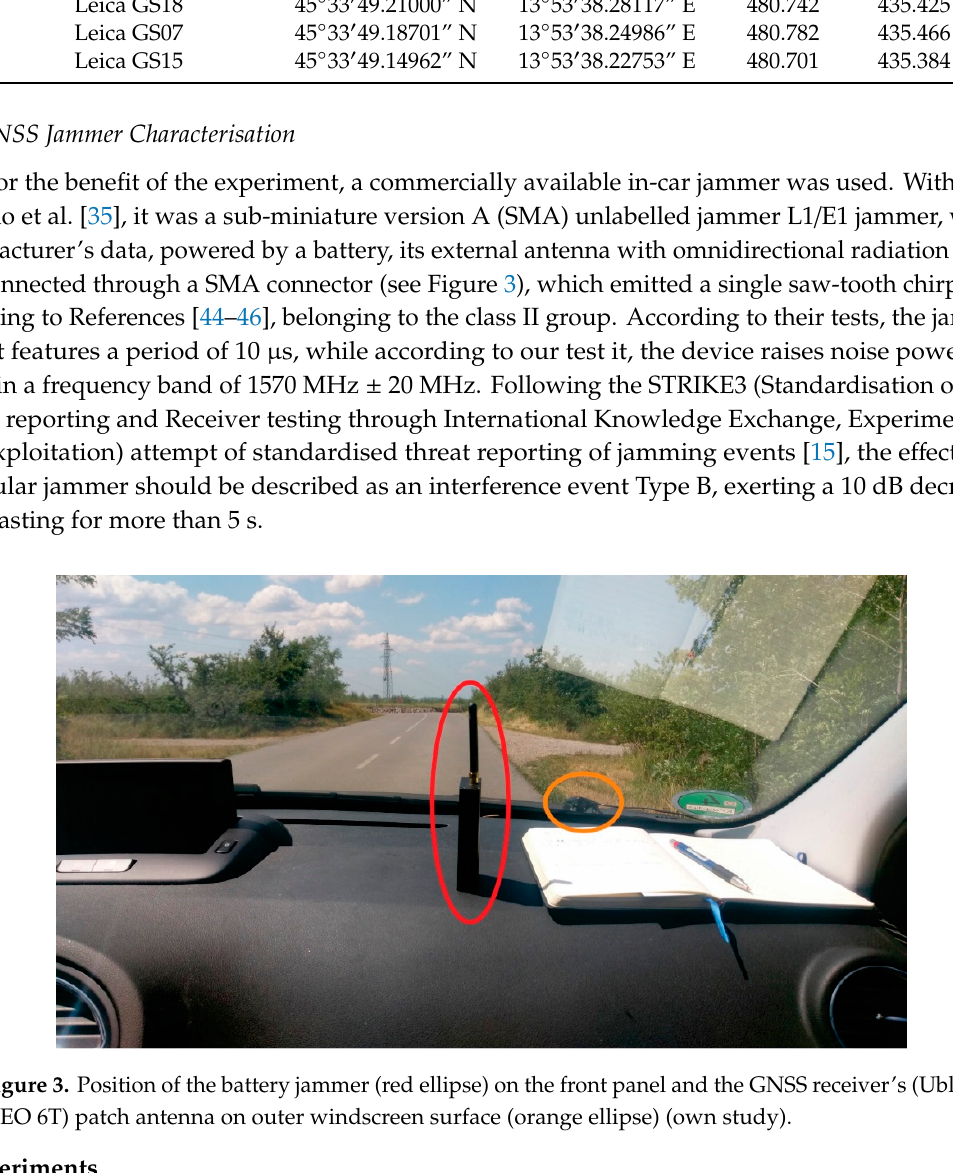
Figure 4. Pre-planned measurement scenarios (own study). GNSS: Global Navigation Satellite System. Experiments involving jamming with the static position of the jammer at the specific point were conducted first; namely, two 3-minute jammings were performed at each of the positions indicated by J1, J2, J3 and J4 (Table 3), which incorporated approximate jammer-receiver distances and the start/end times of the static jamming.